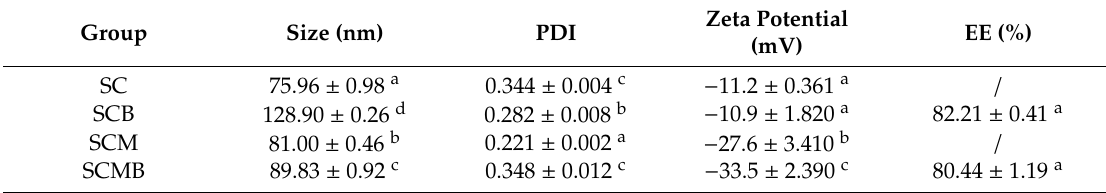
Table 1. The size, PDI, zeta potential and EE of liposomes.